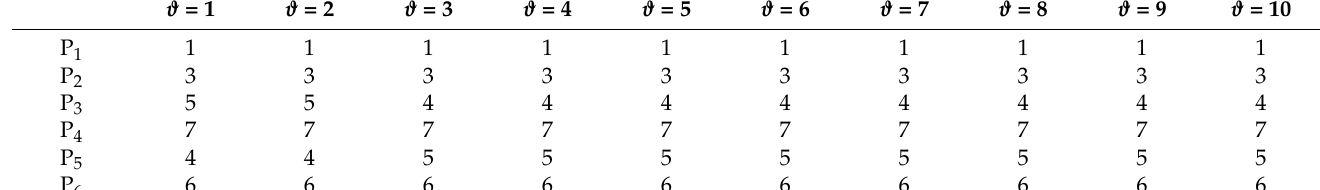
Table 13. The ranking of urban rail transit types under different ϑ values.